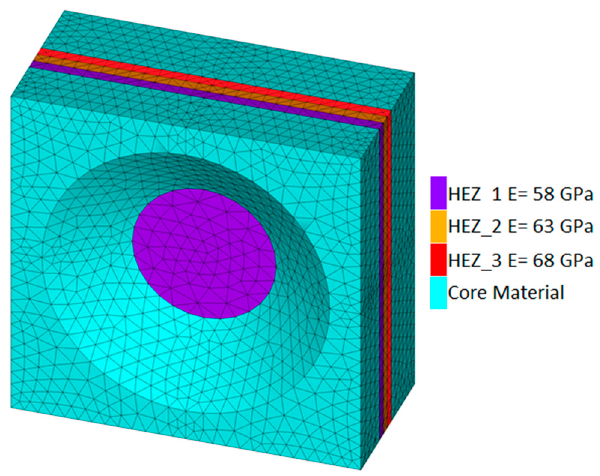
Figure 7. Typical FE mesh and materials employed in the definition of the RUC.